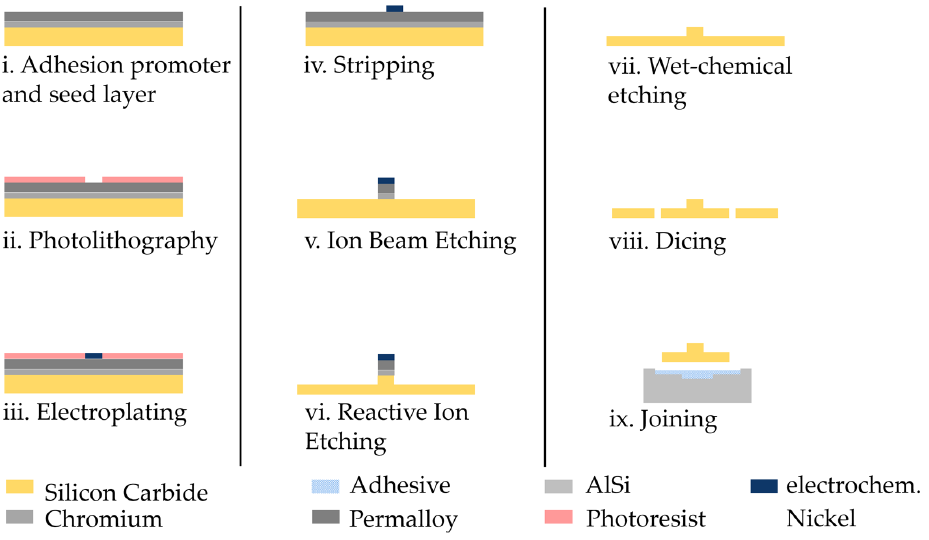
Figure 1. Diagram of the manufacturing process (not to